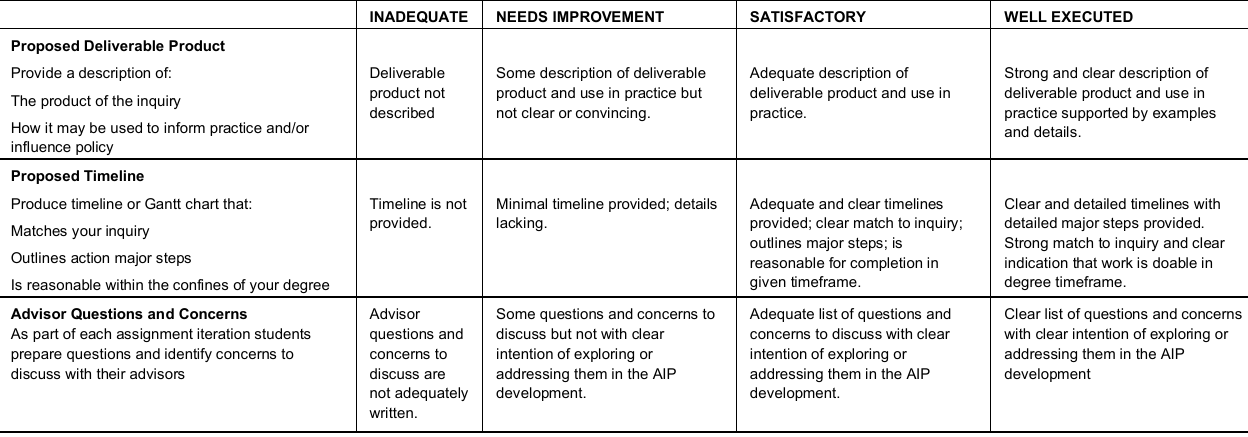
Figure 3. EDUC 3007 Practitioner Inquiry 3: Applied Inquiry